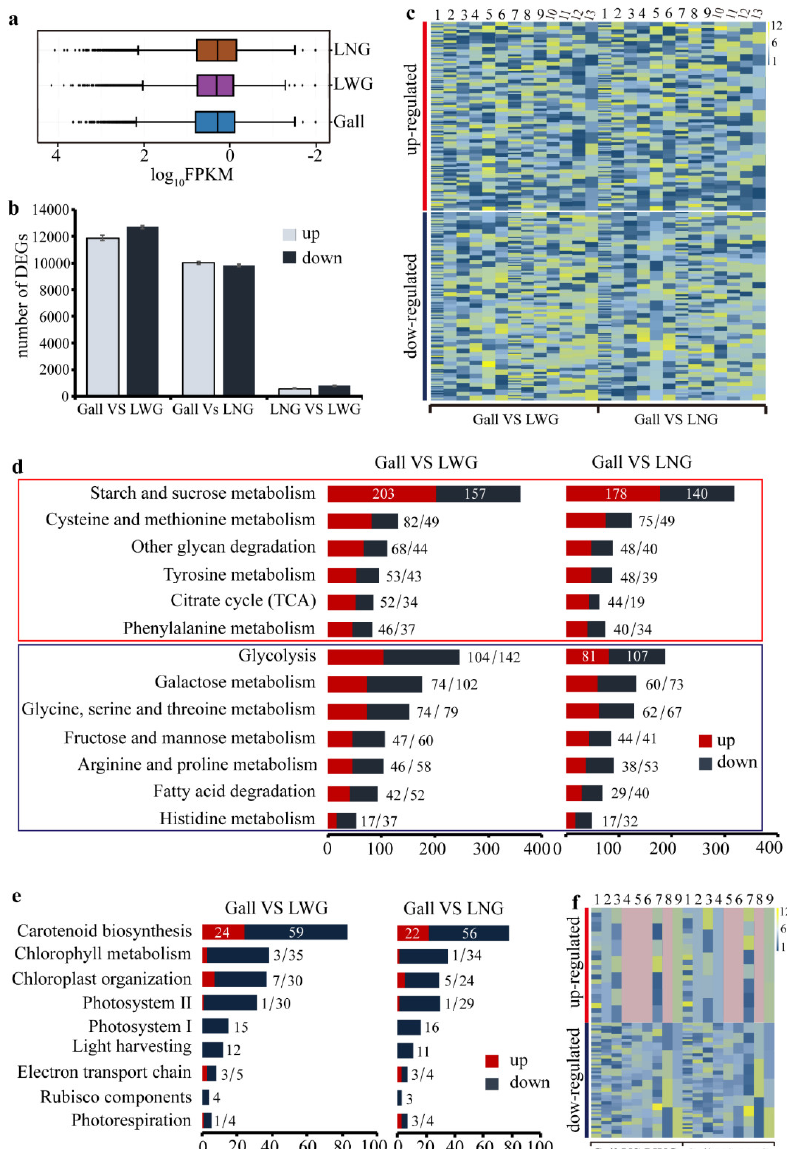
Figure 2. The transcriptomic analysis of the samples. ( a ) Box plot of all gene expressions. ( b ) The number of DEGs in gall vs. LWG, gall vs. LNG, and LNG vs. LWG. ( c ) Heat map of DEGs that regulate metabolism of nutrients in gall vs. LWG (log 2 FoldChange(Gall/LWG)) and gall vs. LNG (log 2 FoldChange(Gall/LNG)). Colors from dark blue to yellow reflect smaller to larger differences. A single block represents a single gene in the map. The numbers at the top of the graph represent different functional categories, with 1 representing starch and sucrose metabolism; 2, cysteine and methionine metabolism; 3, other glycan degradation; 4, tyrosine metabolism; 5, citrate cycle (TCA cycle); 6, phenylalanine metabolism; 7, glycolysis; 8, galactose metabolism; 9, glycine, serine and threonine metabolism; 10, fructose and mannose metabolism; 11, arginine and proline metabolism; 12, fatty acid degradation; 13, histidine metabolism. The numerical order corresponds to the ordinate from top to bottom in figure d. ( d ) DEGs involved in nutrient metabolism. The DEGs were identified in pairs of gall vs. LWG and gall vs. LNG. Up-regulated pathways are marked by red rectangles and down-regulated pathways are marked by dark blue rectangles. ( e ) DEGs involved in photosynthesis based on gall vs. LWG and gall vs. LNG comparisons. All subpathways for photosynthesis were down-regulated in gall tissues. ( f ) Heat map of DEGs related to photosynthesis based on LNG vs. LWG (log 2 FoldChange(LNG/LWG)) comparison. The numbers at the top of the graph represent different subcategories, with 1, carotenoid biosynthesis; 2, chlorophyll metabolism; 3, chloroplast organization; 4, photosystem II; 5, photosystem I; 6, light harvesting; 7, electron transport chain; 8, rubisco components; and 9, photorespiration. Pink represents that no gene was found in this